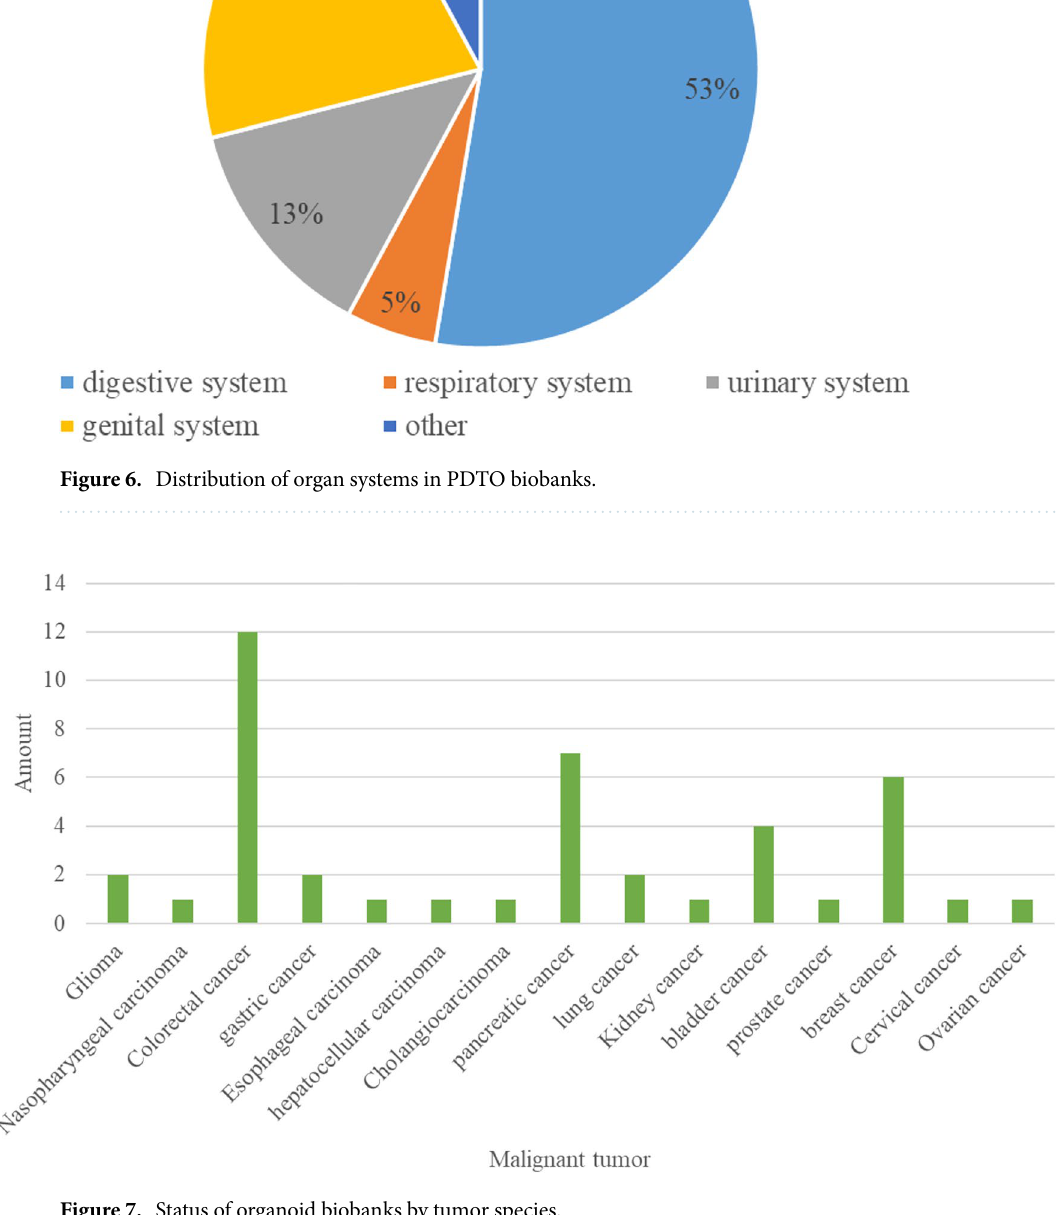
Figure 7. Status of organoid biobanks by tumor